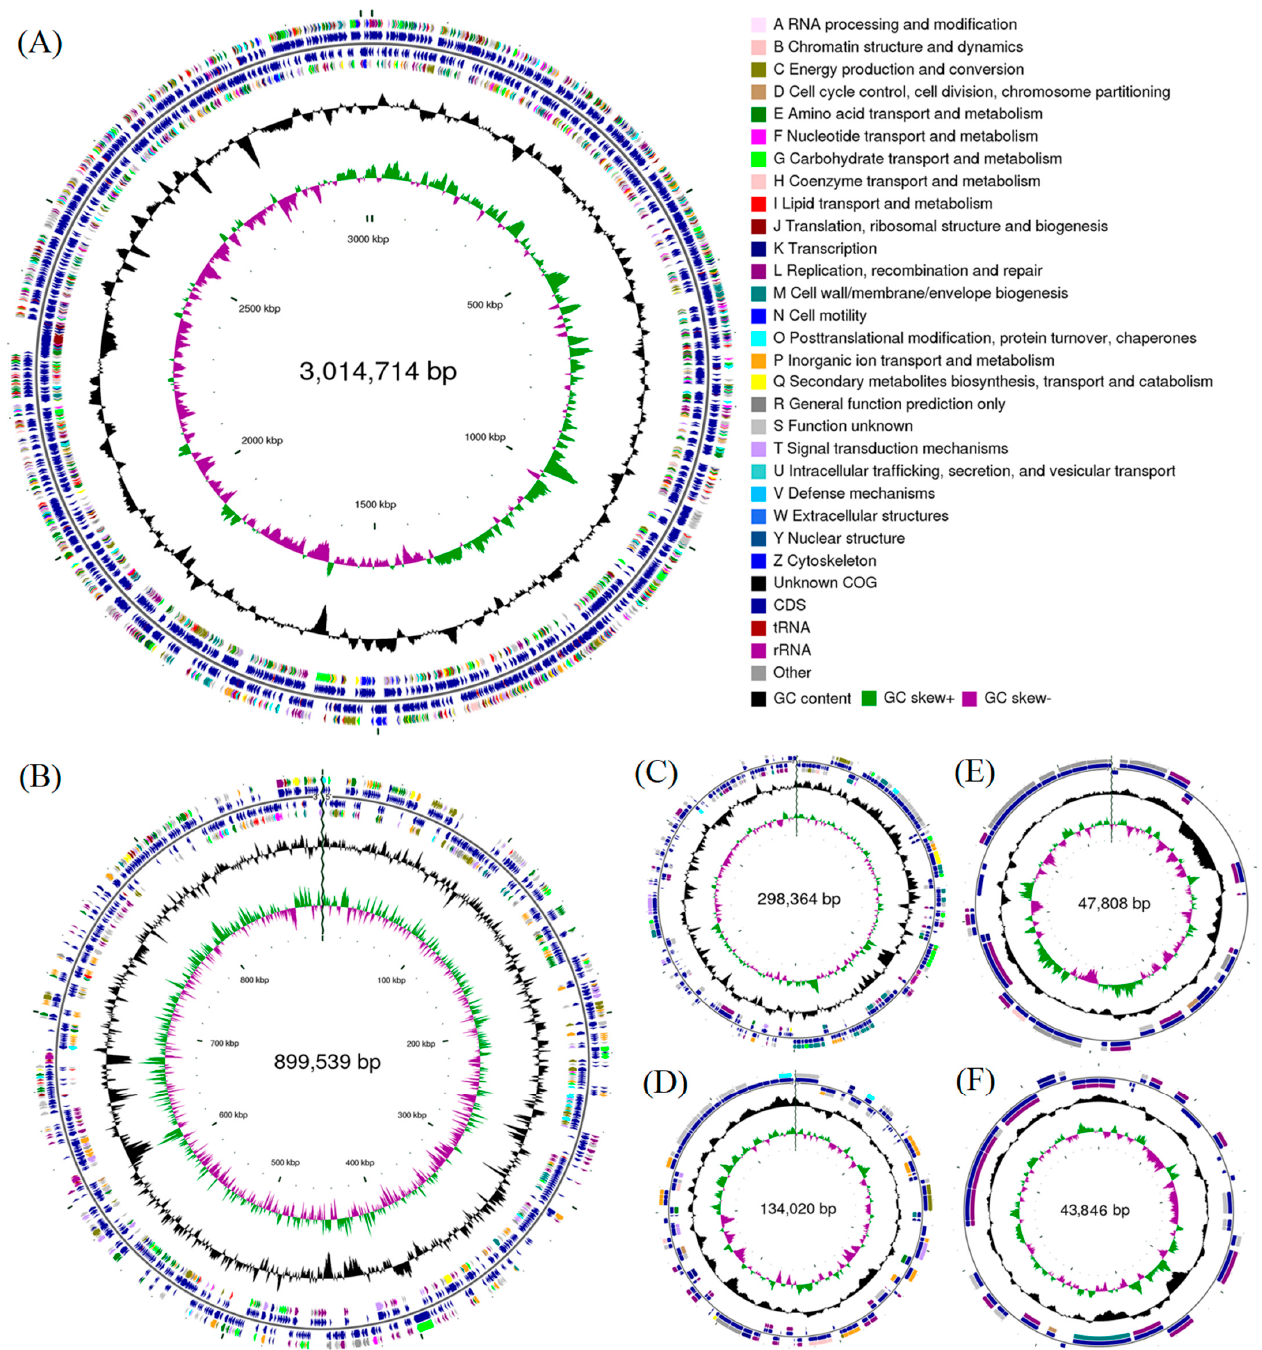
Figure 1. The complete genome map of strain EBL0706, including ( A ) chromosome 1, ( B ) chromosome 2, ( C ) plasmid A, ( D ) plasmid B, ( E ) plasmid C, and ( F ) plasmid D. The features of the marker are displayed from outside to inside as follows: coding sequences (CDSs), colored on clusters of orthologous groups (COG) functional categories, on the forward strand; tRNA and rRNA on the forward and reverse strand; CDSs on the reverse strand; GC content (plotted as the deviation from the average GC content of the entire sequence; outward plots as positive values and inward plots as negative values) and GC skew (G - /G + C, the leading chain and the lagging chain can be judged by the change of GC skew, generally the leading chain GC skew > 0, the lagging chain GC skew <